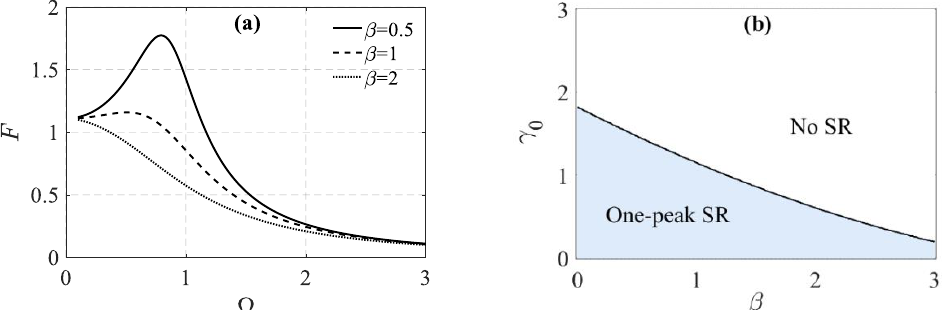
Figure 5. ( a ) Output steady-state amplitude versus excitation frequency with different noise parameter β for the case of fast switching noise. ( b ) Different bona fide patterns occur for different parameters β and γ 0